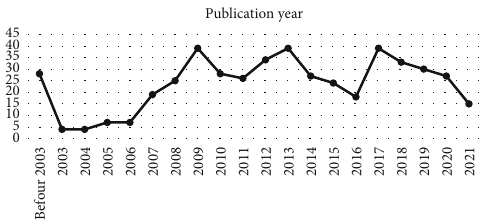
Figure 2: Overview of number of selected articles in